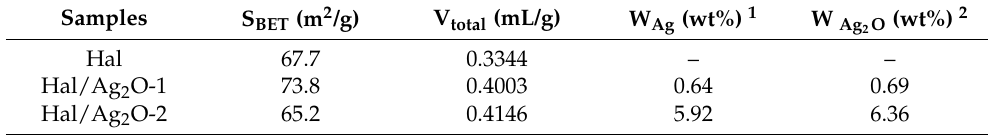
Table 1. Porous structural data, and Ag and Ag 2 O contents of the samples.